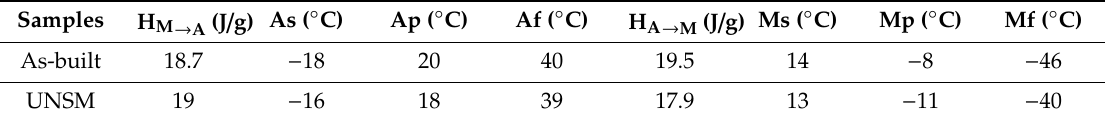
Table 4. Transformation temperatures and enthalpies during the MT of as-built and UNSMed samples.